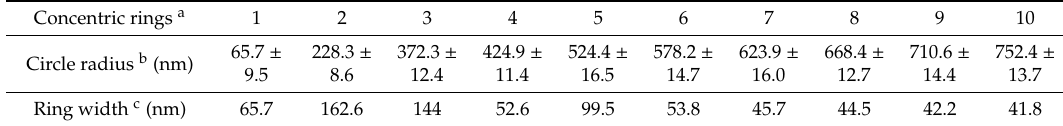
Table 1. Radius and width of distribution of multiple materials in Figure 4g.